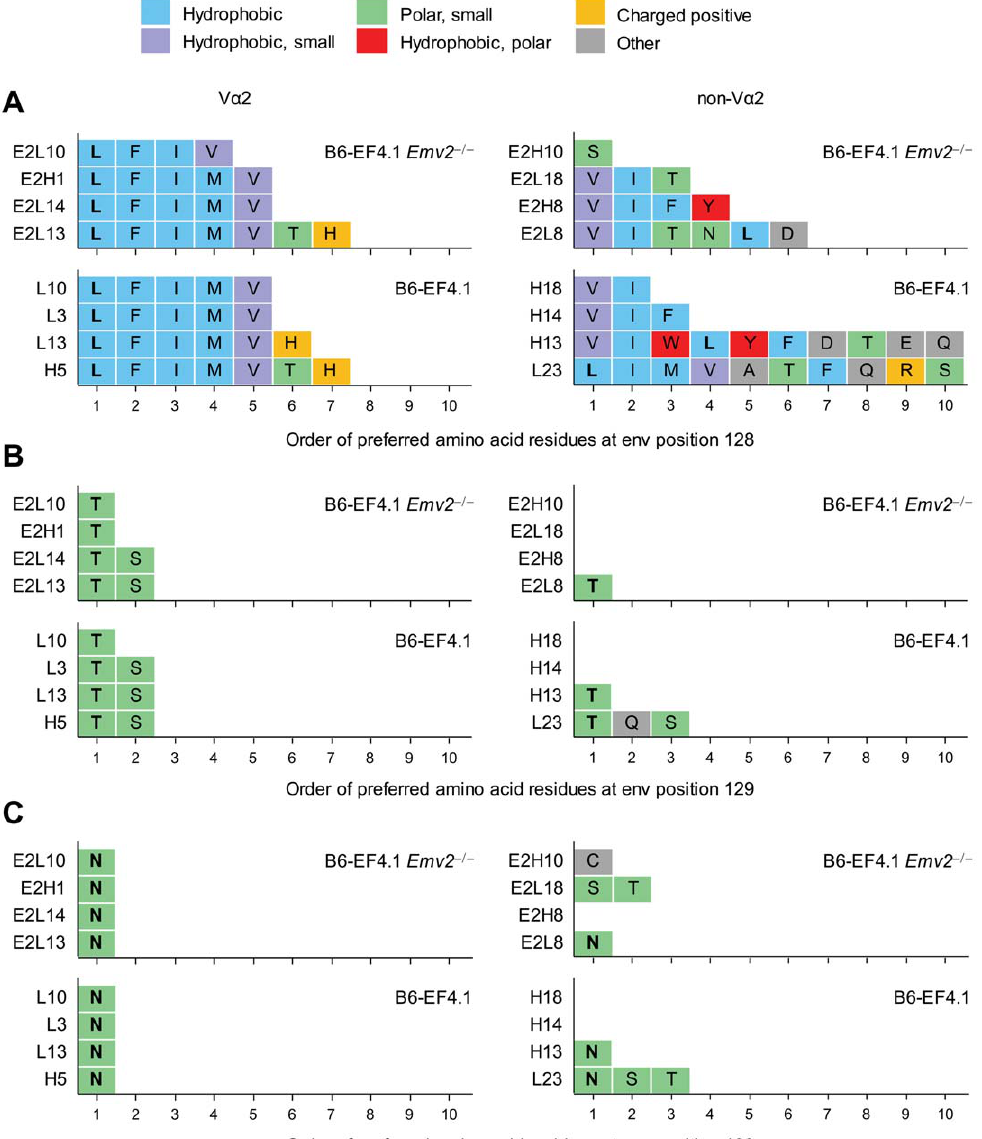
Figure 7. Depth of V a 2 or non-V a 2 env-specific CD4 + T cell repertoires. (A–C) V a 2 or non-V a env 124-138 L-reactive hybridoma T cell lines were derived from Emv2 + / + (B6-EF4.1) or Emv2 2 / 2 (B6-EF4.1 Emv2 2 / 2 ) EF4.1 mice and tested for reactivity against a library of env 126-138 peptide epitopes. The amino acid residues in positions 128 (A), 129 (B) and 133 (C) that elicited at least 40% of the maximal response are listed in the order of preference by the individual